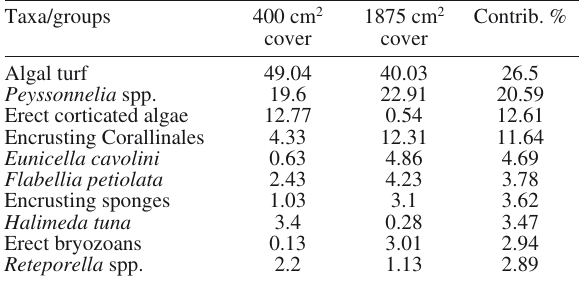
Table 3. – Results of SIMPER test showing taxa/groups responsible for differences between patterns obtained with 400 cm 2 and 1875 cm 2 sampling areas.